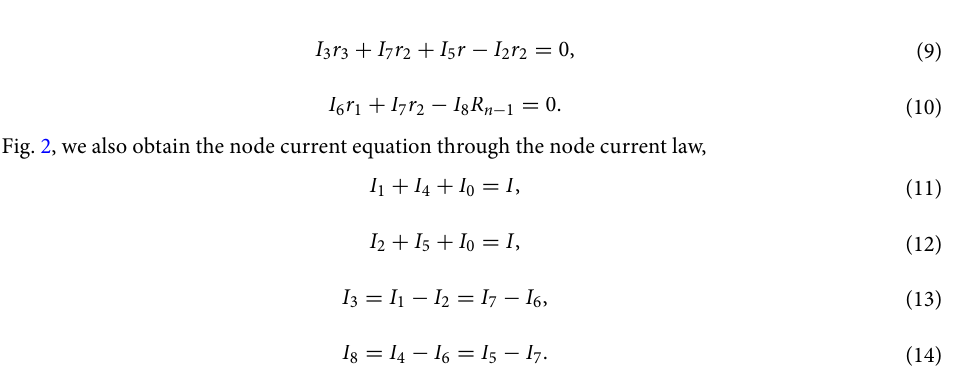
Figure 2. Equivalent model of a bridge circuit network with current